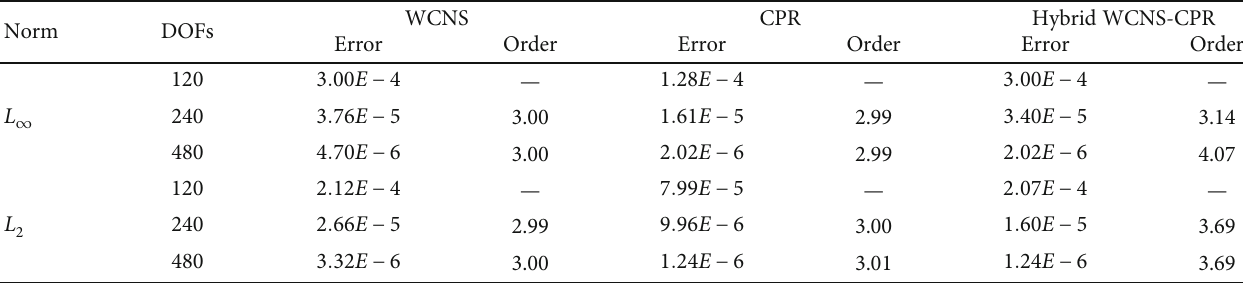
Table 1: Test of single schemes and hybrid WCNS-CPR scheme in ½ − 6, 6 (cid:2) for 1D linear equation.